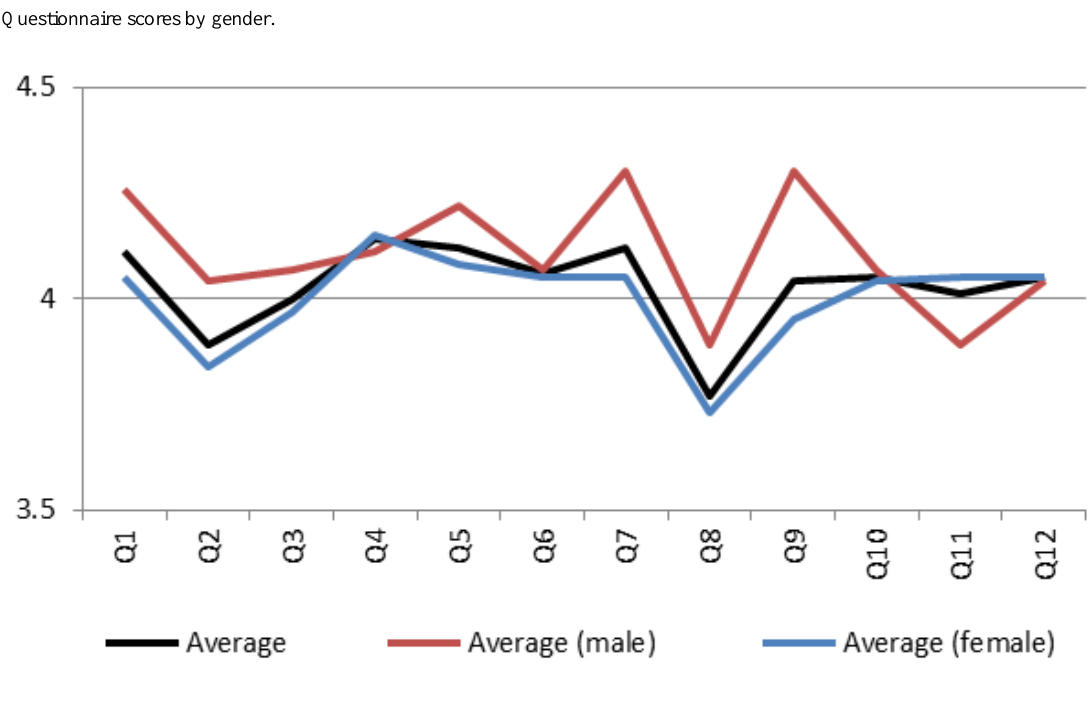
Figure 6. Questionnaire scores by